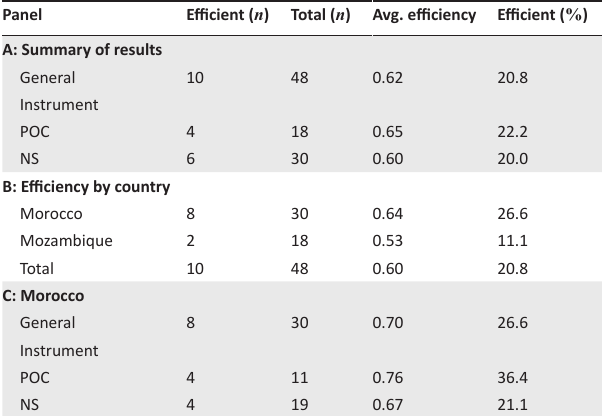
Morocco outperforms Mozambique regarding the level of efficiency achieved in the execution of the ICS. Average